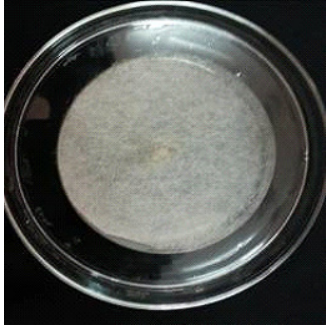
Fig. 9 (B). Mycelial growth of Rhizopus stolonifer After adding 5 ml of distilled distilled water (in the outer dish) and incubated it for one week at